Question: Describe this figure in one sentence.
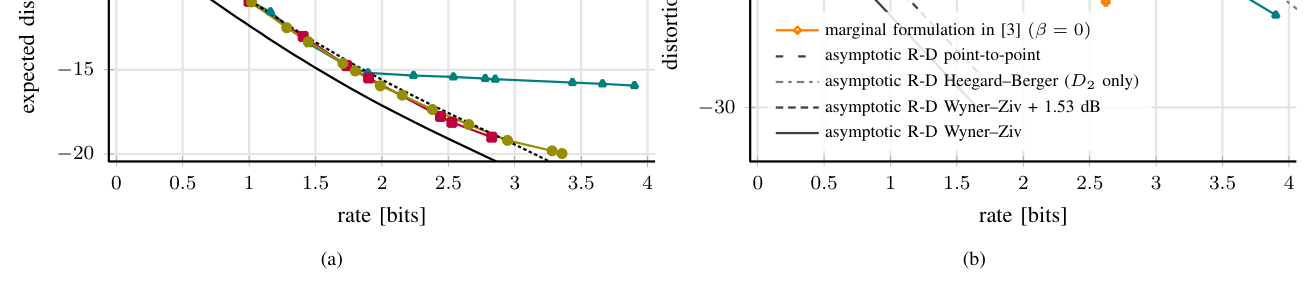
Answer: Rate–distortion (R-D) performances obtained with joint, marginal and conditional formulations (see Eqs. (13), (14) and (15)), where experimental setup parameters (see Section II-B) are set as σ2 x = 1.00, σ2 n = 0.01 and β = 0.20. In both panels, we plot the empirical results versus the asymptotic bounds. We provide the expected distortion achieved by two decoders (see Fig. 2) in the left panel, while we only plot the distortion attained by the informed decoder, which has access to side information, in the right panel. The 1.53 dB refers to the mean-squared error gap that the entropy-constrained one-shot lattice quantizer is subjected to in high-rate regime [19].